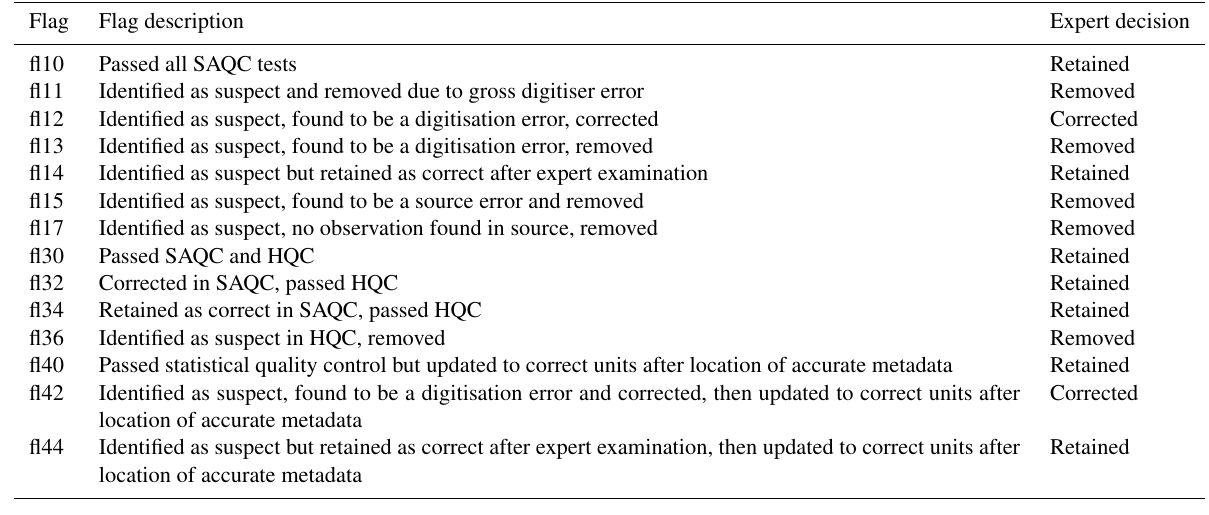
Table 4. Description of quality control flags applied to data during the SAQC and HQC procedures. Flag